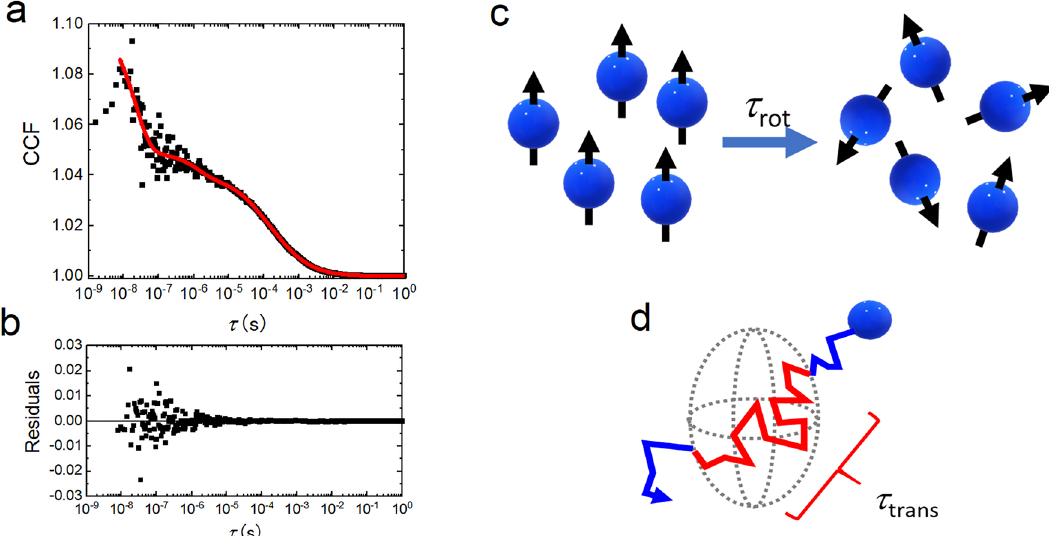
Figure 1. Typical cross-correlation function (CCF) of Pol-FCS measurement. ( a ) Typical CCF of 100 nM GFP in PBS. ( b ) Residuals of fitting analysis. ( c ) Schematic diagram of rotational diffusion time. ( d ) Schematic diagram of translational diffusion